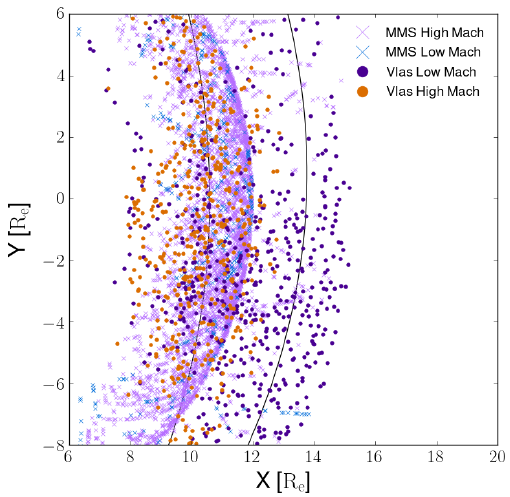
Figure 3. Jets position in the xy plane in the GSE coordinate sys- tem. The jets identified in the four Vlasiator runs described in Ta- ble 1 are shown as purple (orange) dots, which represent low (high) M A from runs LM30 and LM05 (HM30 and HM05), respectively. The total number of jets is 924. Only one position during their life- time is depicted; this is when the jet was at its largest extent. The purple and light blue crosses give the position of the high and low M A MMS jets, respectively. A total of 6142 jets are found from the MMS data. The number of low and high M A categories is 577 and 5533, respectively, for the MMS, using the same M A criterion as for Vlasiator. The approximate magnetopause and bow shock positions are given by solid black lines.